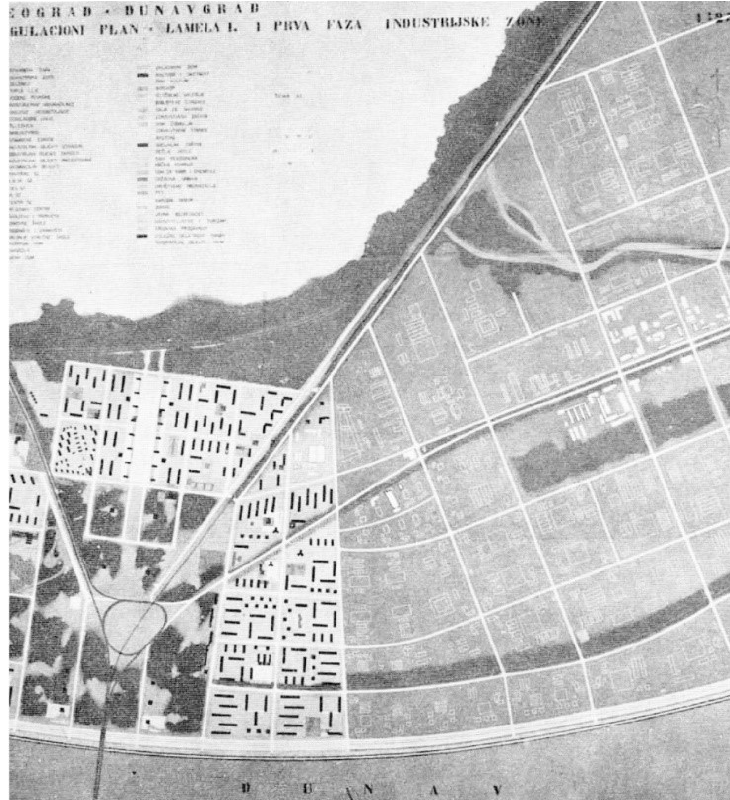
Figure 2. Regulatory plan for the first region of the Danube–city—Belgrade on the left bank of the Danube drafted by the Planning Directorate and the construction of Belgrade on the left bank of the Danube under the leadership of Arch. B. Stojanović (design team: Arch. A. Stjepanović, Arch. B. Janković with associates) in 1958. Source: [44]